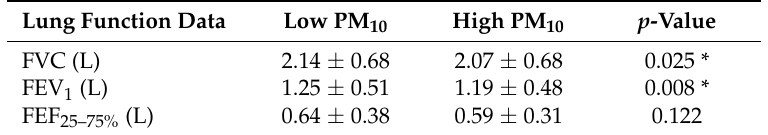
Table 4. Lung function in the period of high PM 10 versus the period of low PM 10